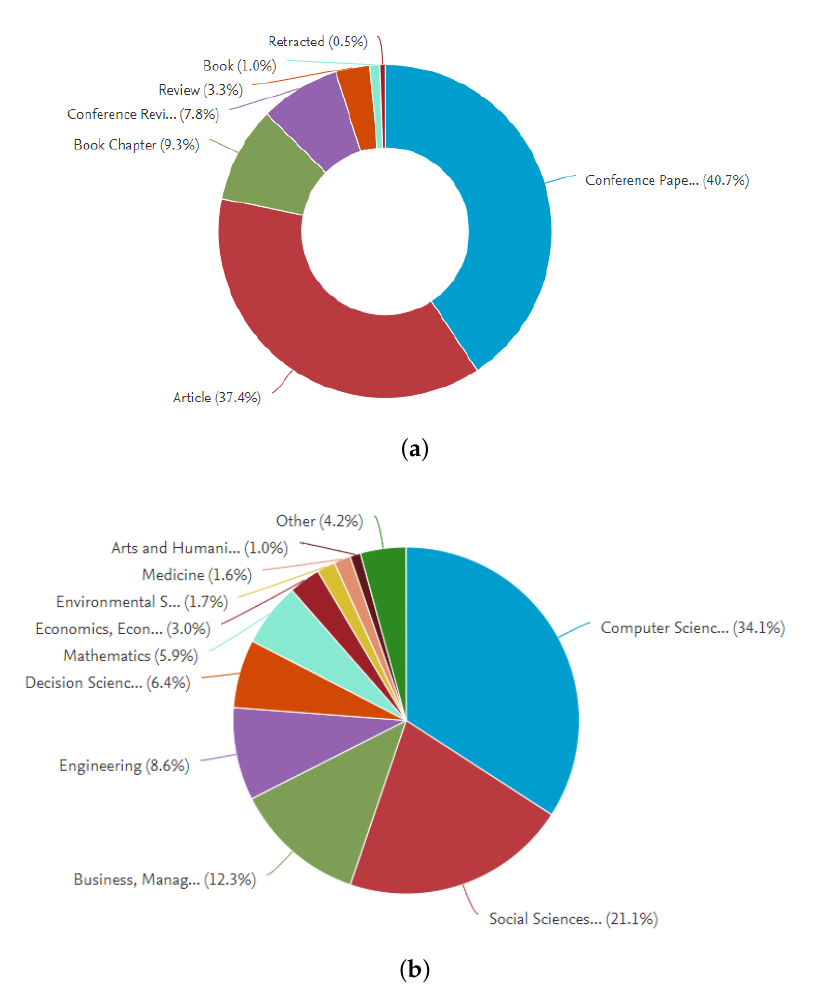
Figure 3. Classification of the documents retrieved by ( a ) type of publication and ( b )